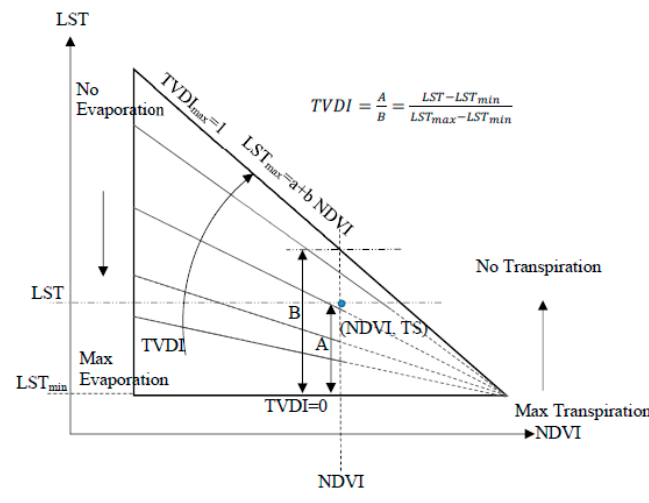
Figure A2. A description of the LST–NDVI space and TVDI calculations.